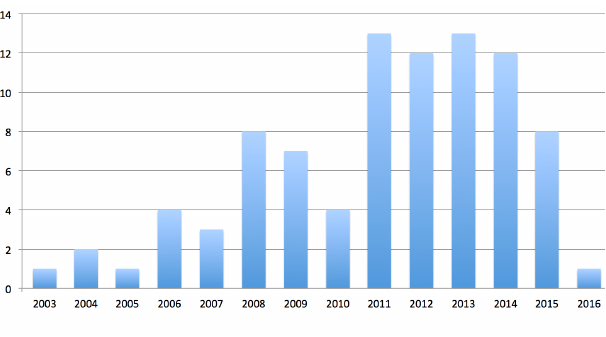
Fig. 1 . Number of publications over